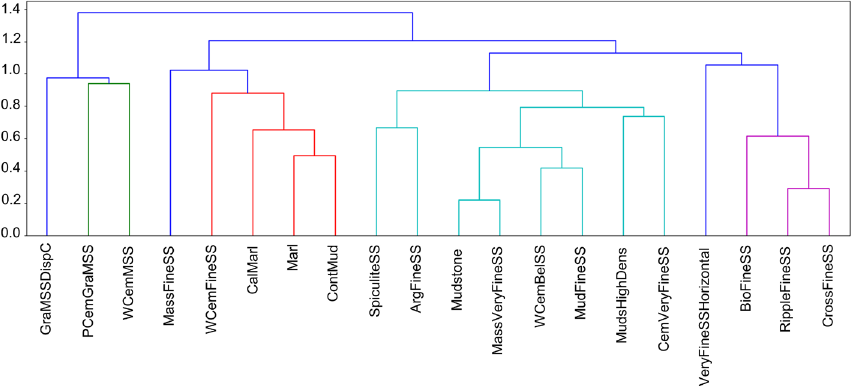
Fig. 14 Dendrogram of the process of clustering the lithofacies classes together using as a distance metric the confusion matrix that has been calculated by the proposed CNN classification